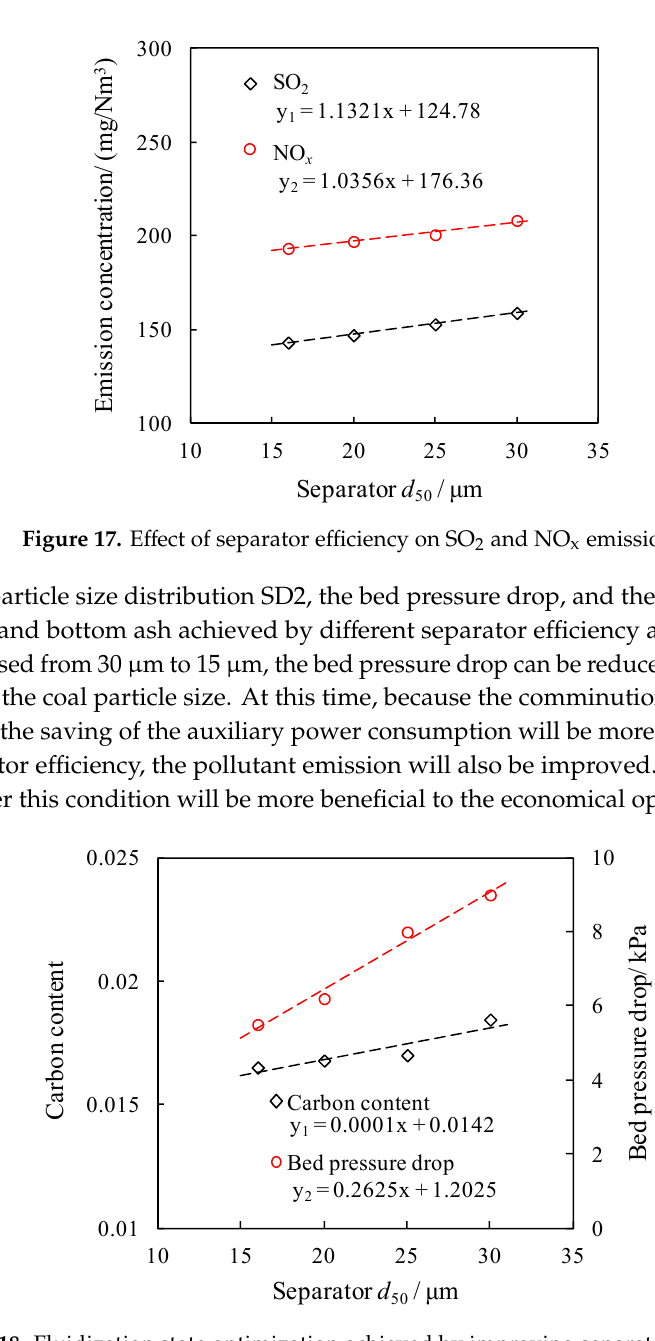
Figure 18. Fluidization state optimization achieved by improving separator efficiency.